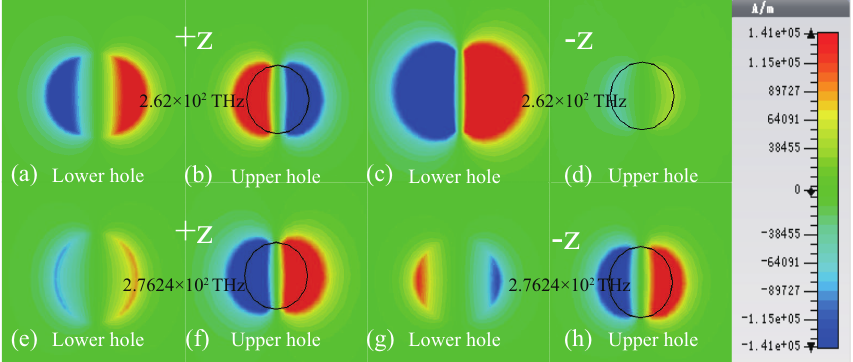
Figure 4. (Color online) z-component distributions of magnetic field of the two gold resonators at 262 THz ( a – d ) and 276.24 THz ( e – h ) when distance s = 275 nm in +z and − z directions, respectively.